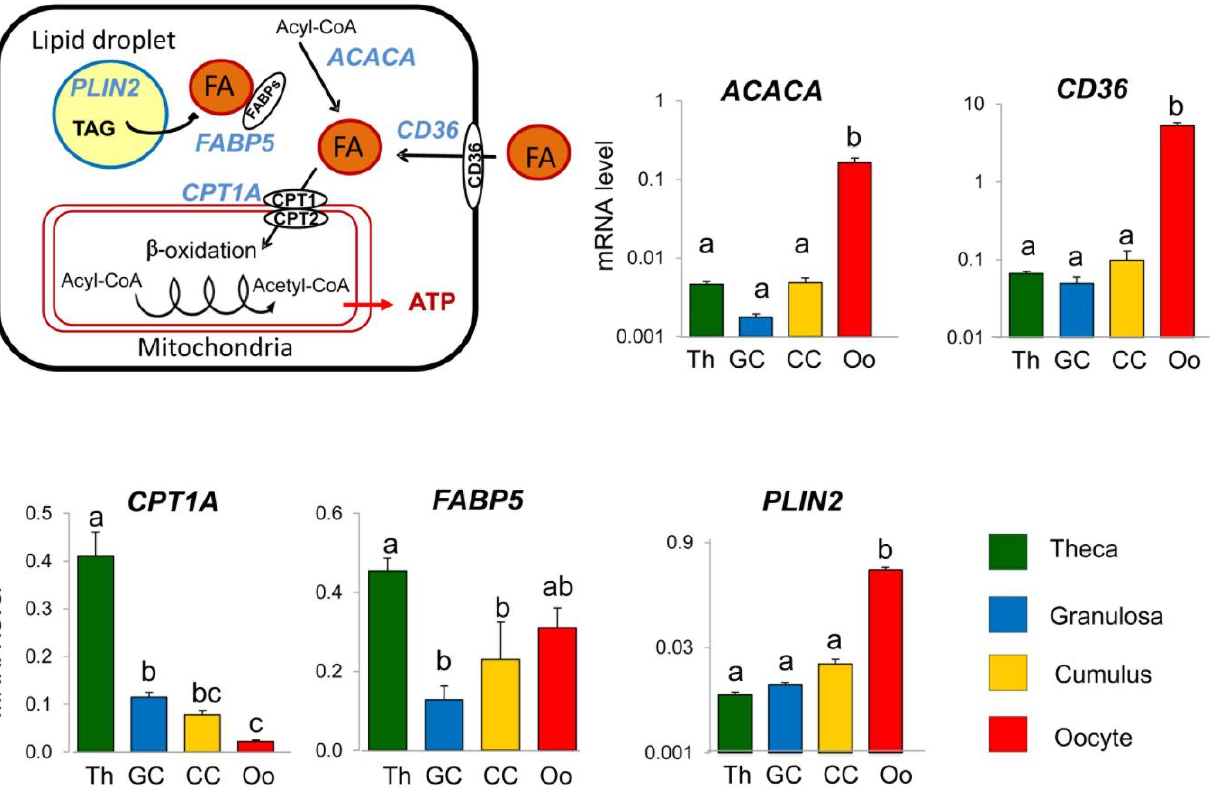
Figure 8. Gene expression analysis of lipid metabolism-related genes ACACA , CD36 , CPTA1 , FABP5 and PLIN2 in porcine follicular compartments (Th, GC, CC and oocyte) by real time qPCR. Histograms present mRNA expression values ± SEM of 8–12 independent samples per